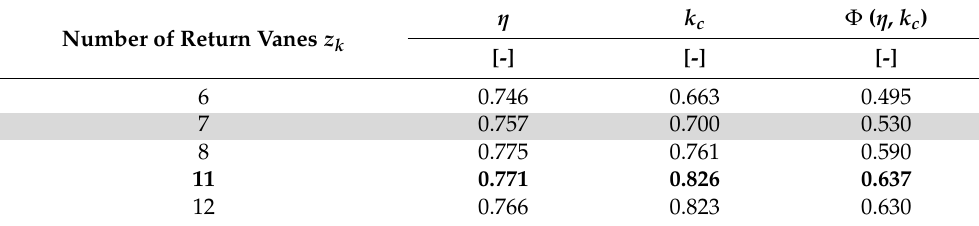
Table 8. The effect of the number of guide vanes.